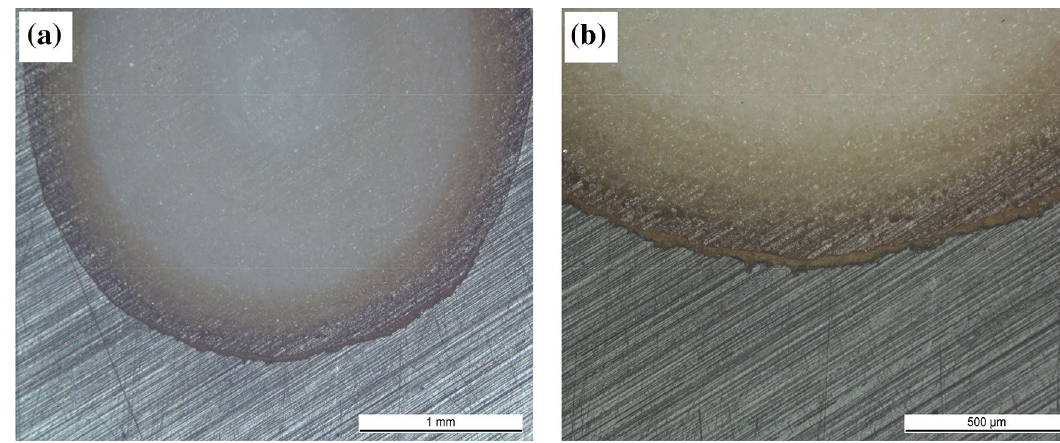
Fig. 3 Optical microscope image of the layer surface ( a ) and the layer cross section ( b ) of a Ni-MOF-74@Al